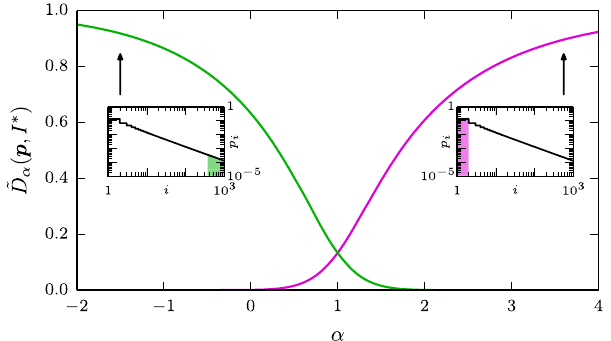
q i ∈ f A; C; D; E; F; G; H g , i ¼ i ) for